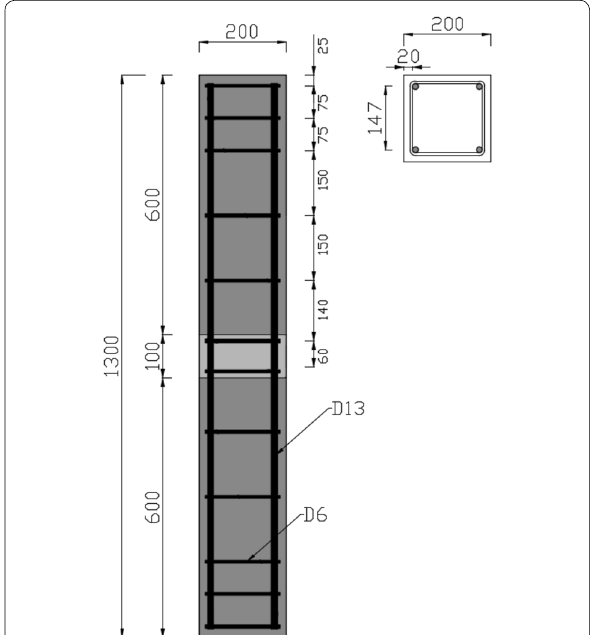
Fig. 4 Specimen details (units : mm).